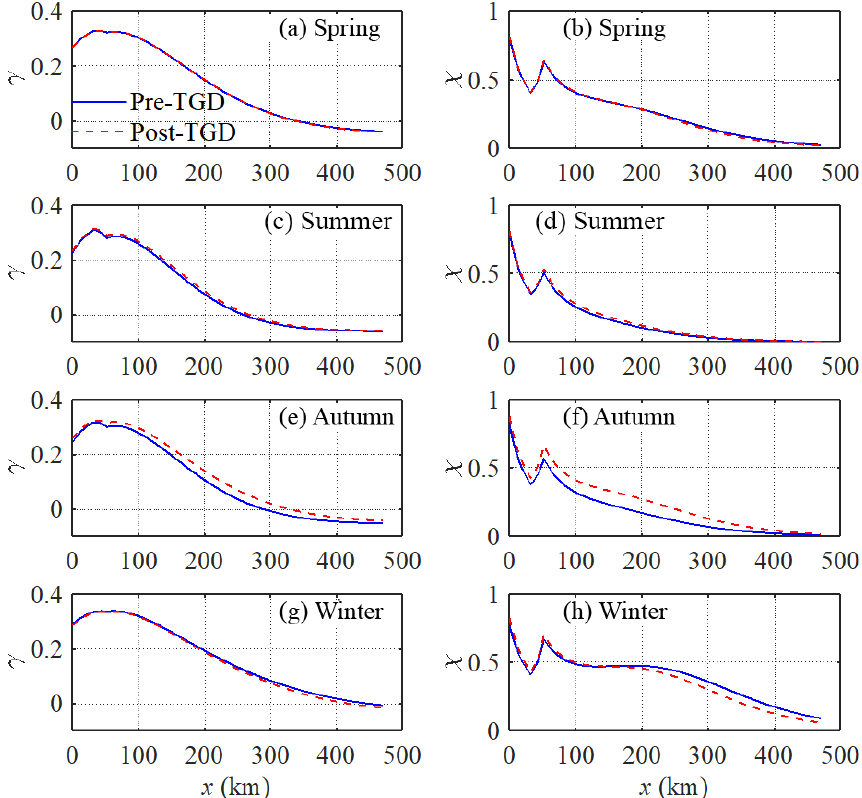
Figure 8. Longitudinal variability of simulated estuary shape number γ (a, c, e, g) and friction number χ (b, d, g, i) along the Yangtze estuary in different seasons (spring: a, b ; summer: c, d ; autumn: e, g ; winter: g, i ) for both the pre-TGD and post-TGD